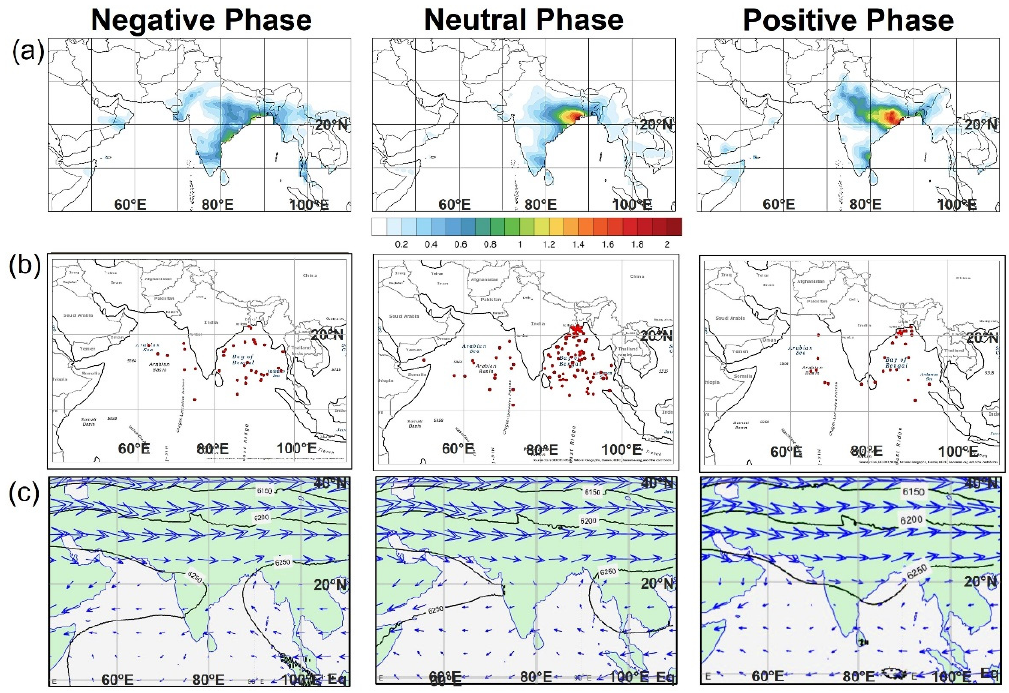
Figure 7. Patterns separated by IOD phase: ( a ) average annual landfalling TC frequency; ( b ) TC genesis locations indicated by red dots; and ( c ) 200–850 hPa deep layer steering flow (blue vectors) and 500-hPa geopotential heights (black contours) averaged from May to November (1989–2018)).